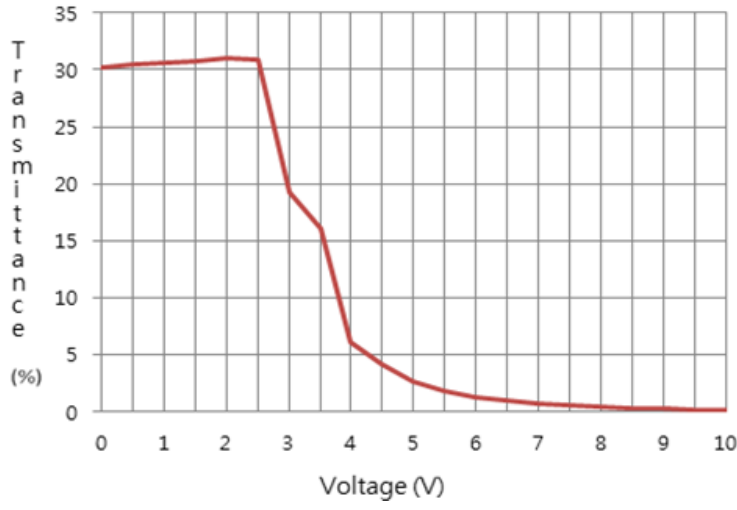
Figure 3. Light transmittance with the applied voltage of the flexible liquid crystal lens fabricated on PC